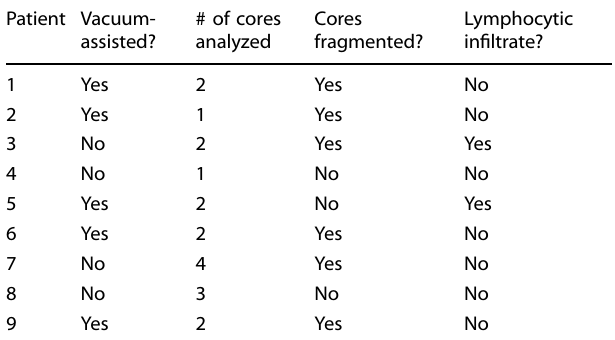
Table 2. Pathologic characteristics of core biopsy